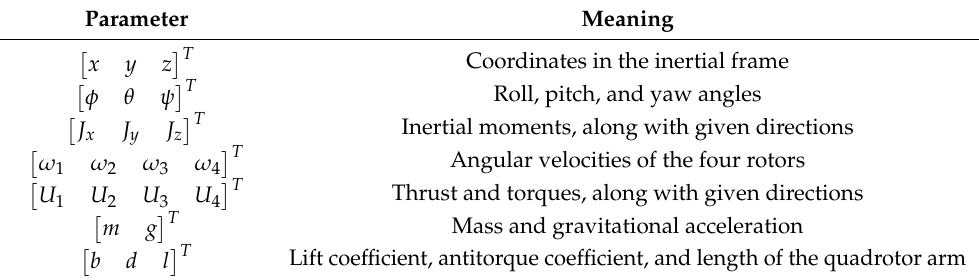
Table 1. Parameters of QUAV